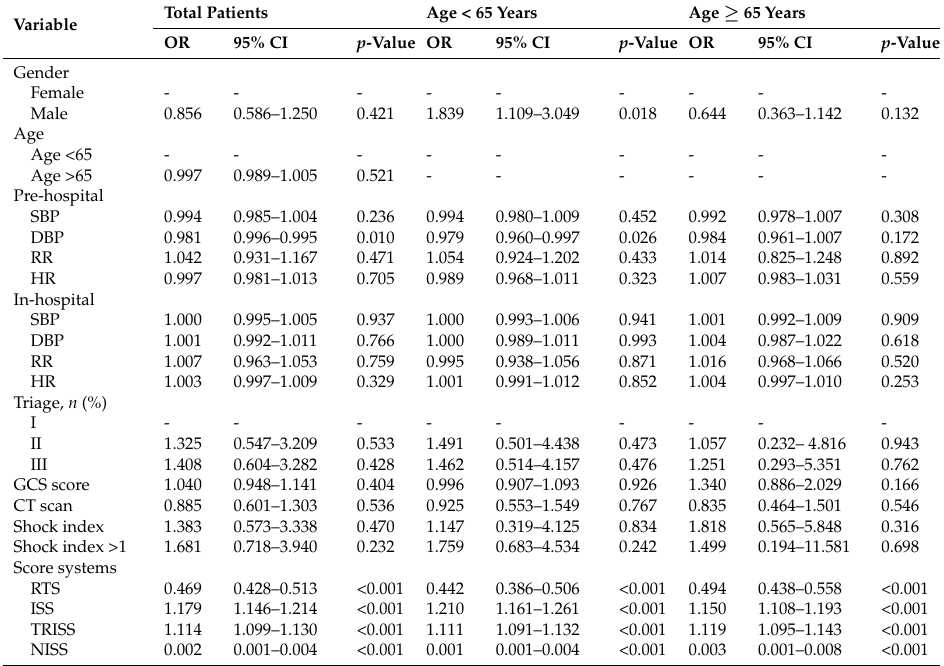
Table 5. Logistic regression analysis of clinical parameters between the younger and elderly patient